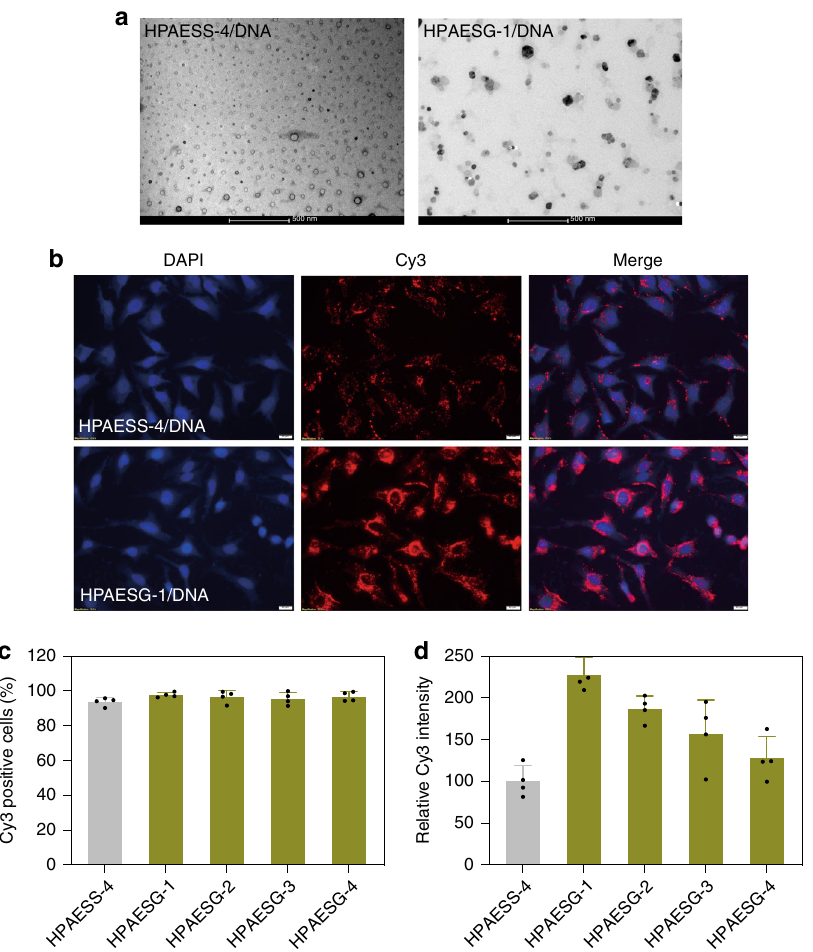
Fig. 6 Improvement of polyplex cellular uptake by guanidinylation of HPAESSs. a TEM images show that HPAESS-4/DNA and HPAESG-1/DNA polyplexes have different morphologies, the former is uniform and toroidal while the latter is polyhedral, the scale bars present 500 nm. b Fluorescence images of HeLa cells after incubation with HPAESS-4/DNA and HPAESG-1/DNA polyplexes for 4 h at the w / w ratio of 20:1, the latter clearly show higher cellular uptake ef fi ciency, the scale bars present 20 μ m. c The cellular uptake ef fi ciency of different HPAESG/DNA polyplexes showing similar percentages of Cy3- positive HeLa cells. d Cells after treatment with HPAESG/DNA polyplexes have higher relative fl uorescence intensity than the HPAESS/DNA counterparts. Data are shown as average ± SD; n =